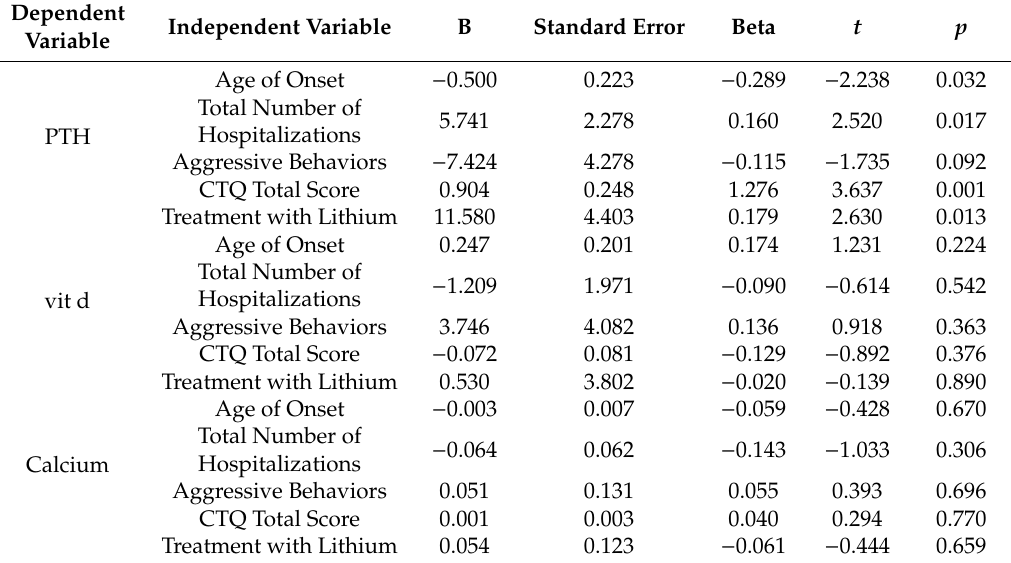
Table 4. Linear regression